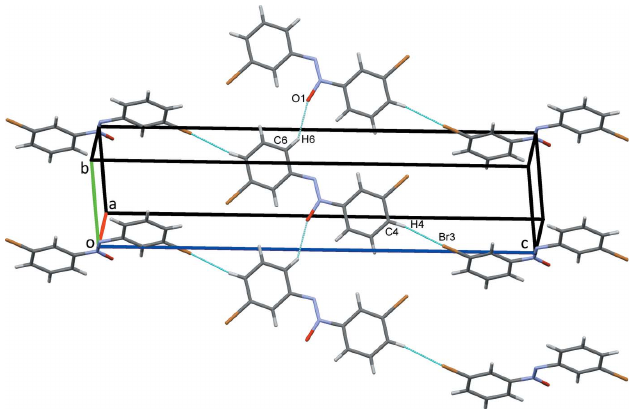
Figure 2 Sheets of molecules of (I) with hydrogen bonds shown as blue dashed lines.